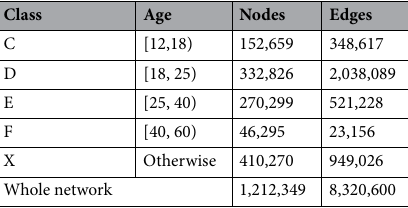
Table 3. Classes of Pokec social network. For each class the number of nodes is reported, with the number of edges joining nodes in the same class.